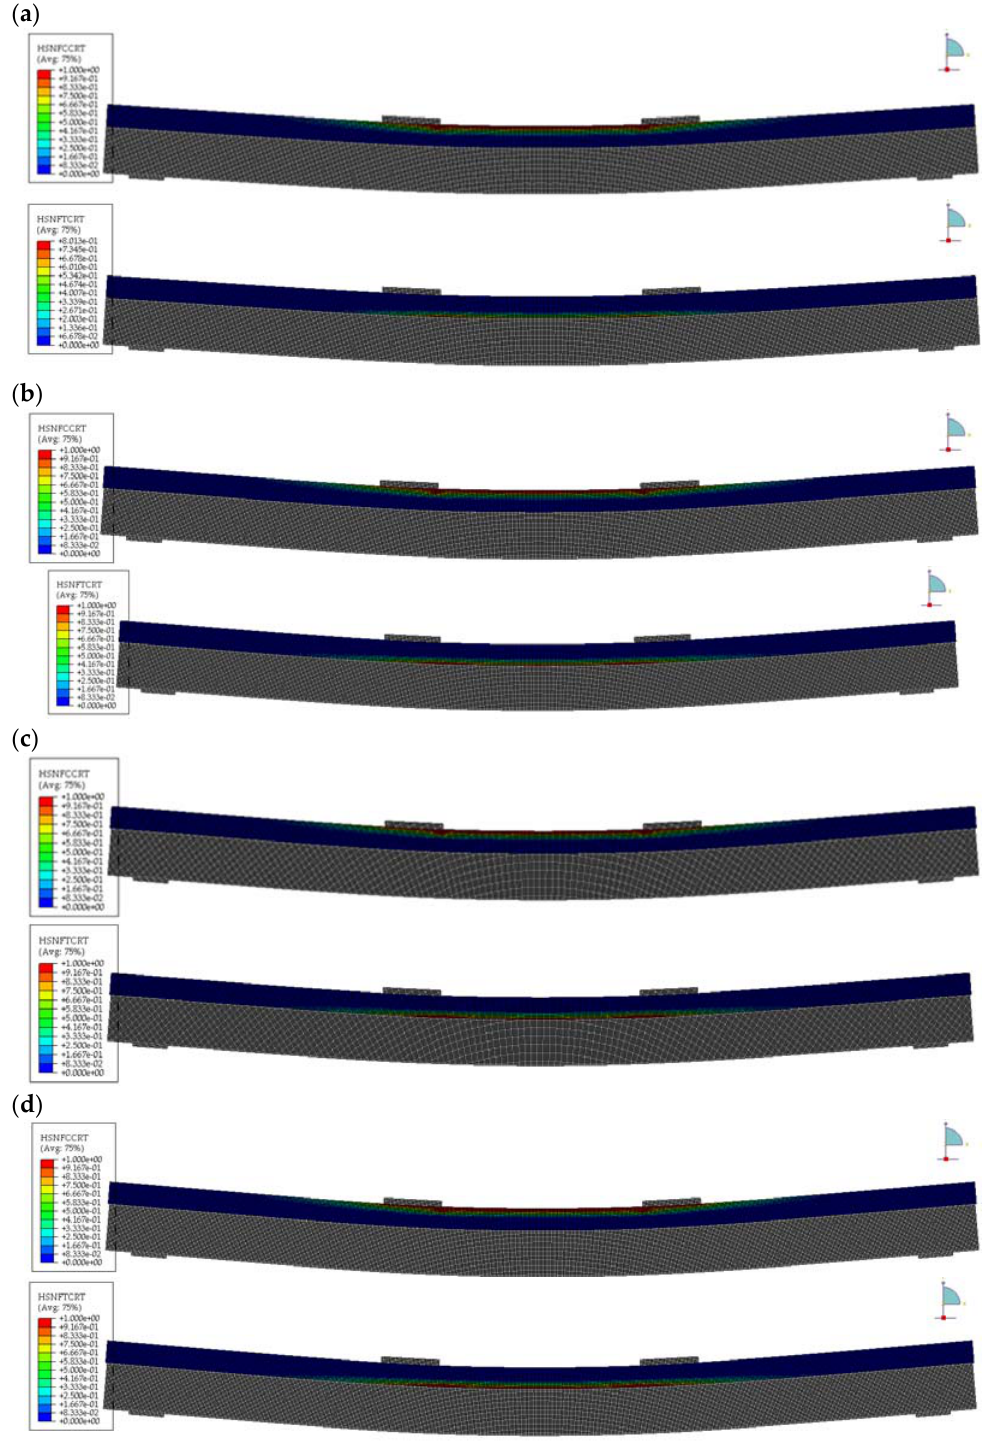
Figure 17. The areas of damage initiation. Due to the compression of the fibres and due to the tension of the fibres for the ultimate load ( M pl = 68.7 kN · m) and the composite beam with full shear connection ( a ), for the ultimate load ( M pl = 64.4 kN · m) and the B120 beam ( b ), for the ultimate load ( M pl = 63.3 kN · m) and the B160 beam ( c ), for the ultimate load ( M pl = 63.9 kN · m) and the B200 beam ( d ).